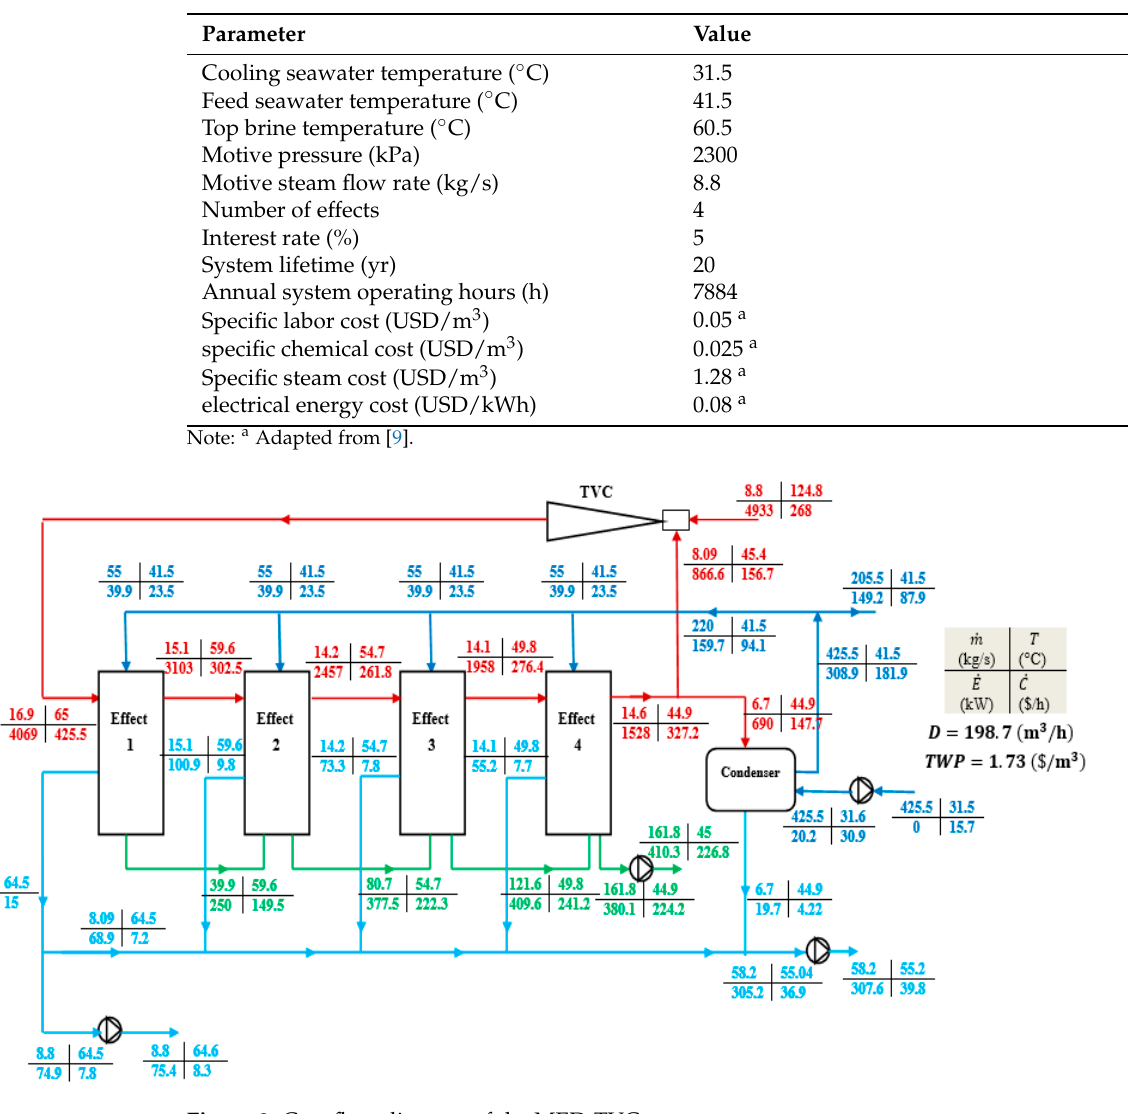
Figure 2. Cost flow diagram of the MED-TVC system.